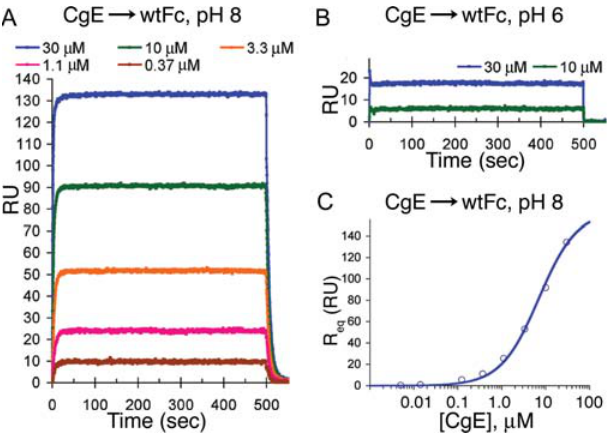
Figure 1. Binding of CgE to Fc at pH 8 and pH 6 (A and B) Sensorgrams collected from the indicated concentrations of CgE injected at pH 8 (A) or pH 6 (B) over a flow cell coupled with wtFc. (C) Plot of equilibrium-binding response (R eq ) versus concentration of CgE at pH 8 derived from biosensor data shown in (A). The best-fit binding curve to the experimental data points (open circles) is shown as a continuous line. DOI: